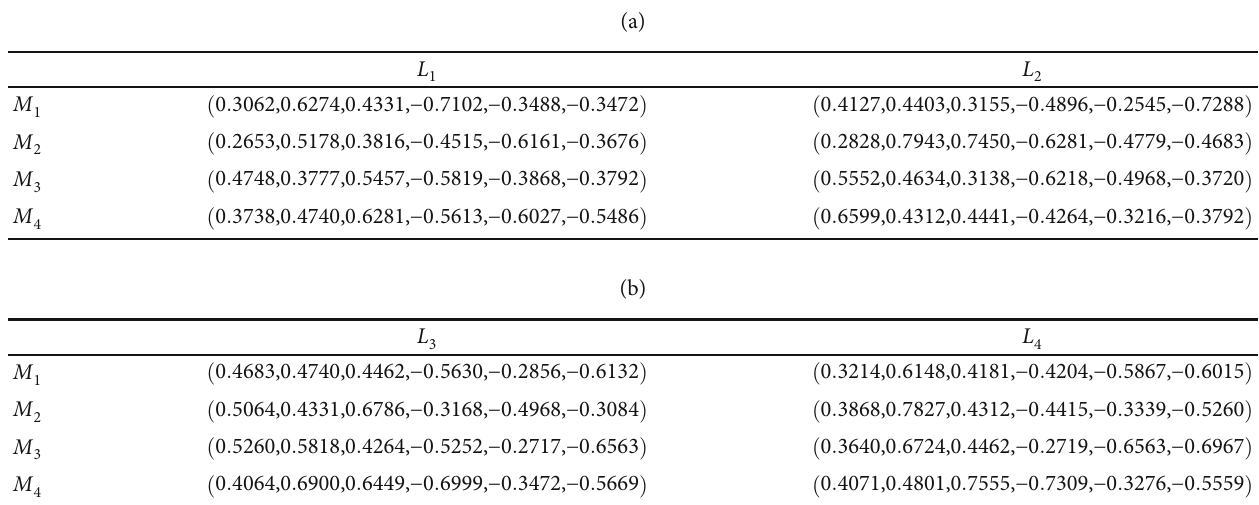
Table 4: Collective BNN decision matrix R .